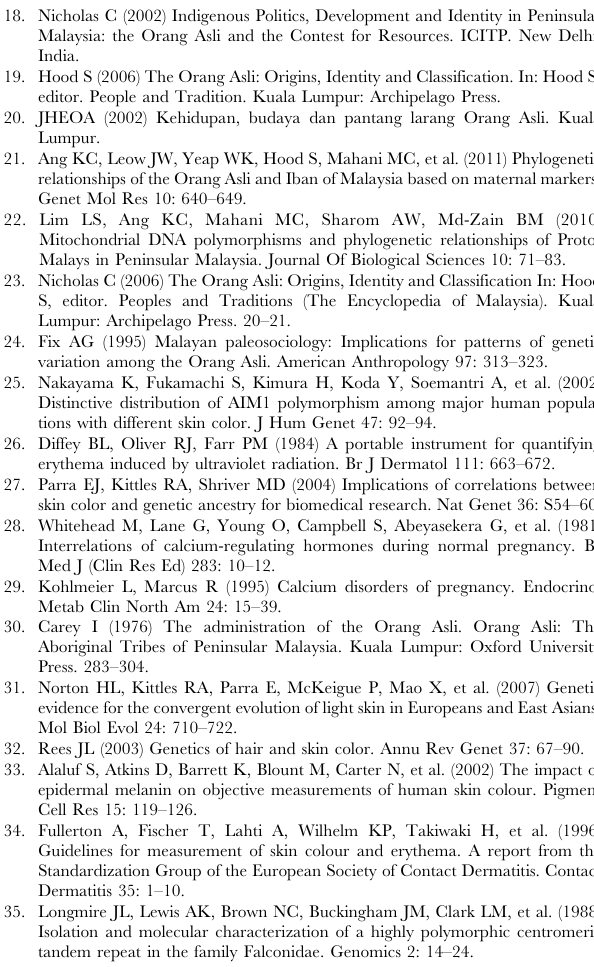
Figure S1 M-indices of all sampled Orang Asli with clear genotype. This plot includes individuals with either ancestral or derived alleles for SLC24A2 and SLC45A2 ( n = 492). (TIF) Figure S2 Distribution of Orang Asli M-indices based on sex for all Orang Asli samples. The average M-index of males was darker than that of females by 3 M-index units ( n = 517, ANOVA, p , 0.0001, R 2 = 3.2%). This plot includes individuals whose DNA did not yield clear genotype for alleles at SLC24A5 or SLC45A2 . (TIF)